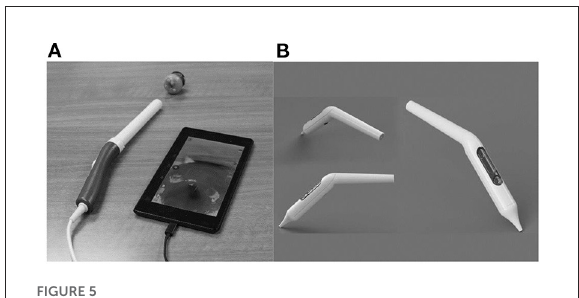
FIGURE7 The ZedScan cervical